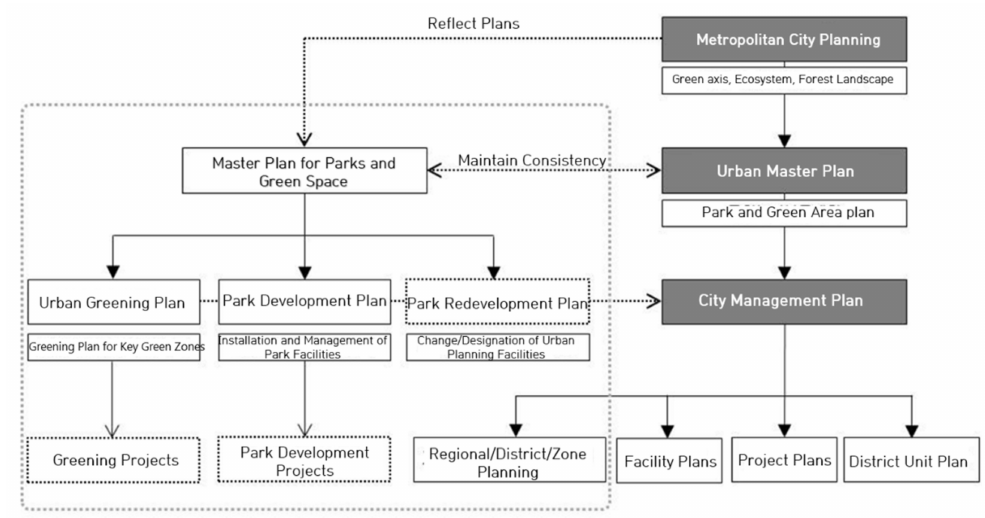
Figure 2. The Status of the Seoul Parks and Green Space Master Plan and the establishment procedure